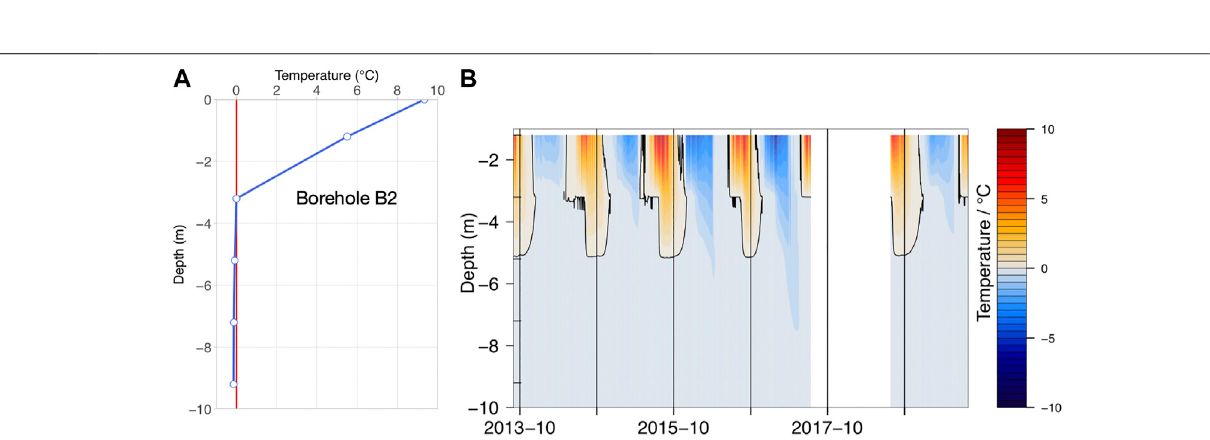
FIGURE2|(A) Temperaturepro fi lefortheuppermost10 m(1.5 – 10 m)registeredinboreholeSchafbergB1onJuly30,2019,bluecirclesdenotethedepthsofthe thermistors. (B) Contour plot of borehole temperature data from 1.5 to 10 m depth from 2013 to 2019, showing that unfrozen zones (taliks) are present around 4.7 and 6.7 m depth. Vertical black lines indicate the start of hydrological years (October